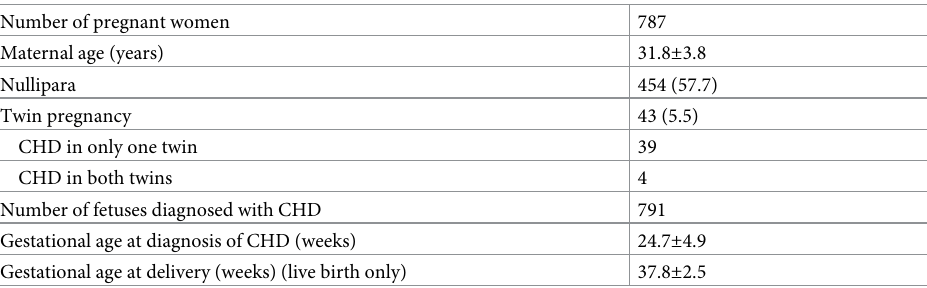
Table 1. Maternal